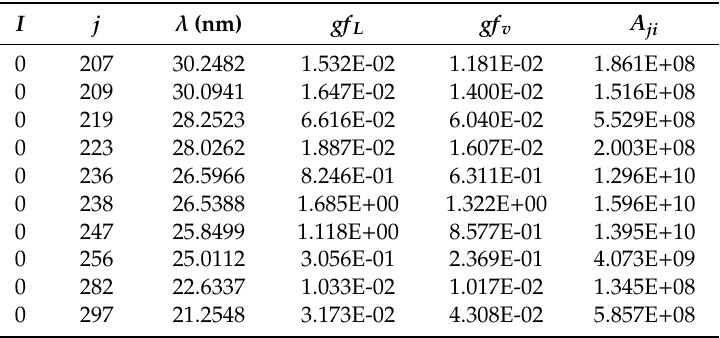
Figure 1. Comparison of theoretical wavelengths with the experimental wavelengths of Reference λ (in nm), [30]. Table 3. Oscillator strengths (length and velocity form) gf L and gf v , vacuum wavelengths and transition probabilities A ji (in s − 1 ) for some strong electric dipole (E1) transitions from the ground state to various levels of Eu-like